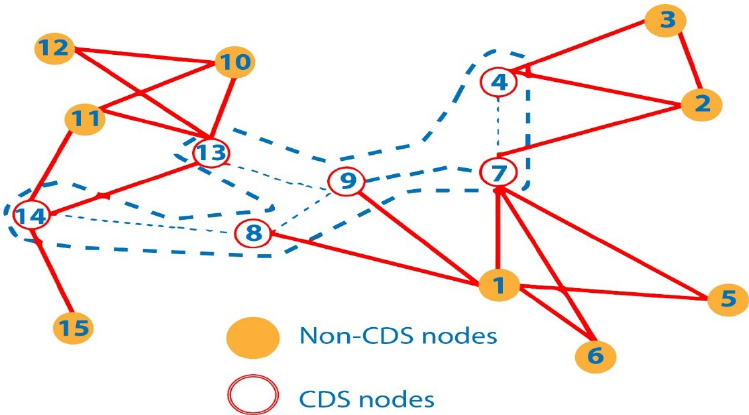
Figure 1. Sensor nodes identity represent in digits for AUV trajectory with HC.